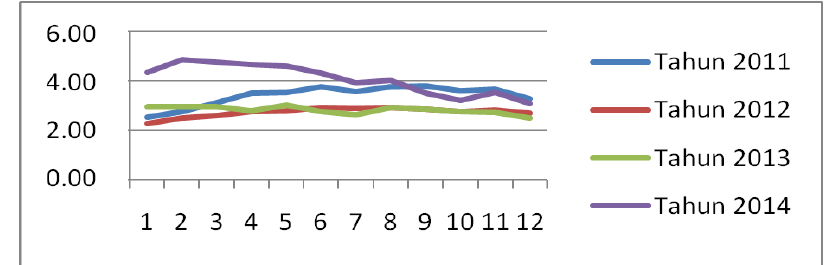
Fig. 3. Chart of problematic financing in